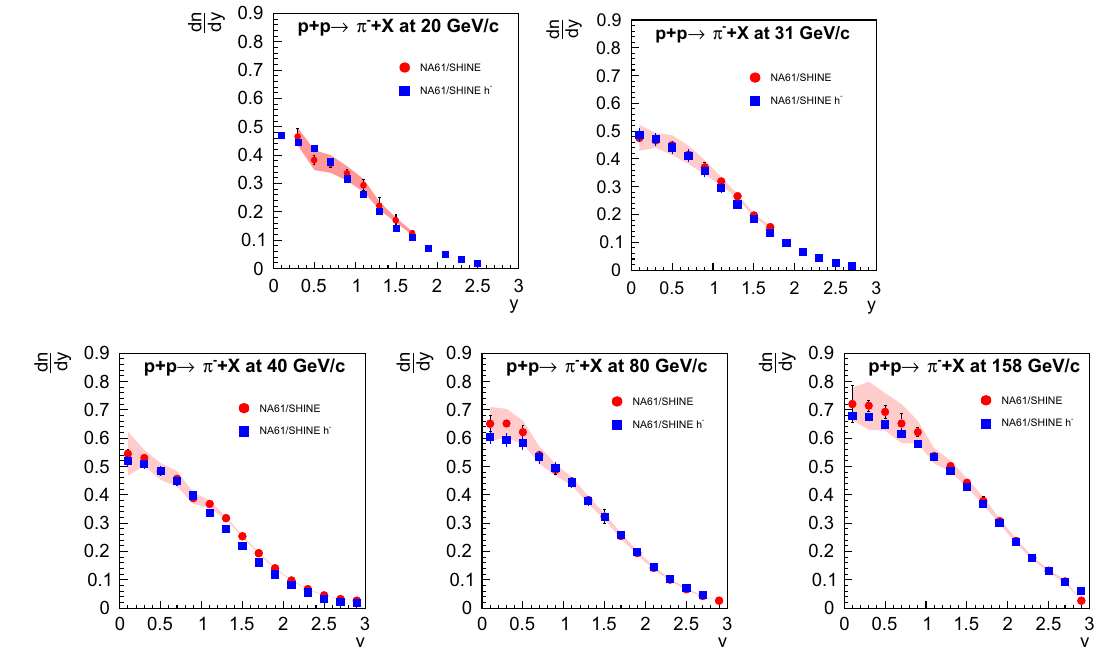
Fig. 21 Comparison of π − rapidity distributions obtained by d E / d x and tof -d E / d x methods with results from the h − technique [3]. The h − results are presented with statistical uncertainty. Red shaded bands